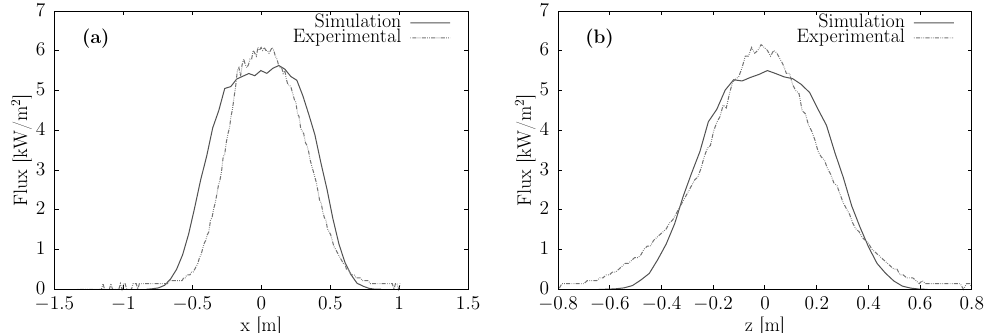
Figure 18. Irradiance distributions along the x ( a ) and z ( b ) directions through the distribution